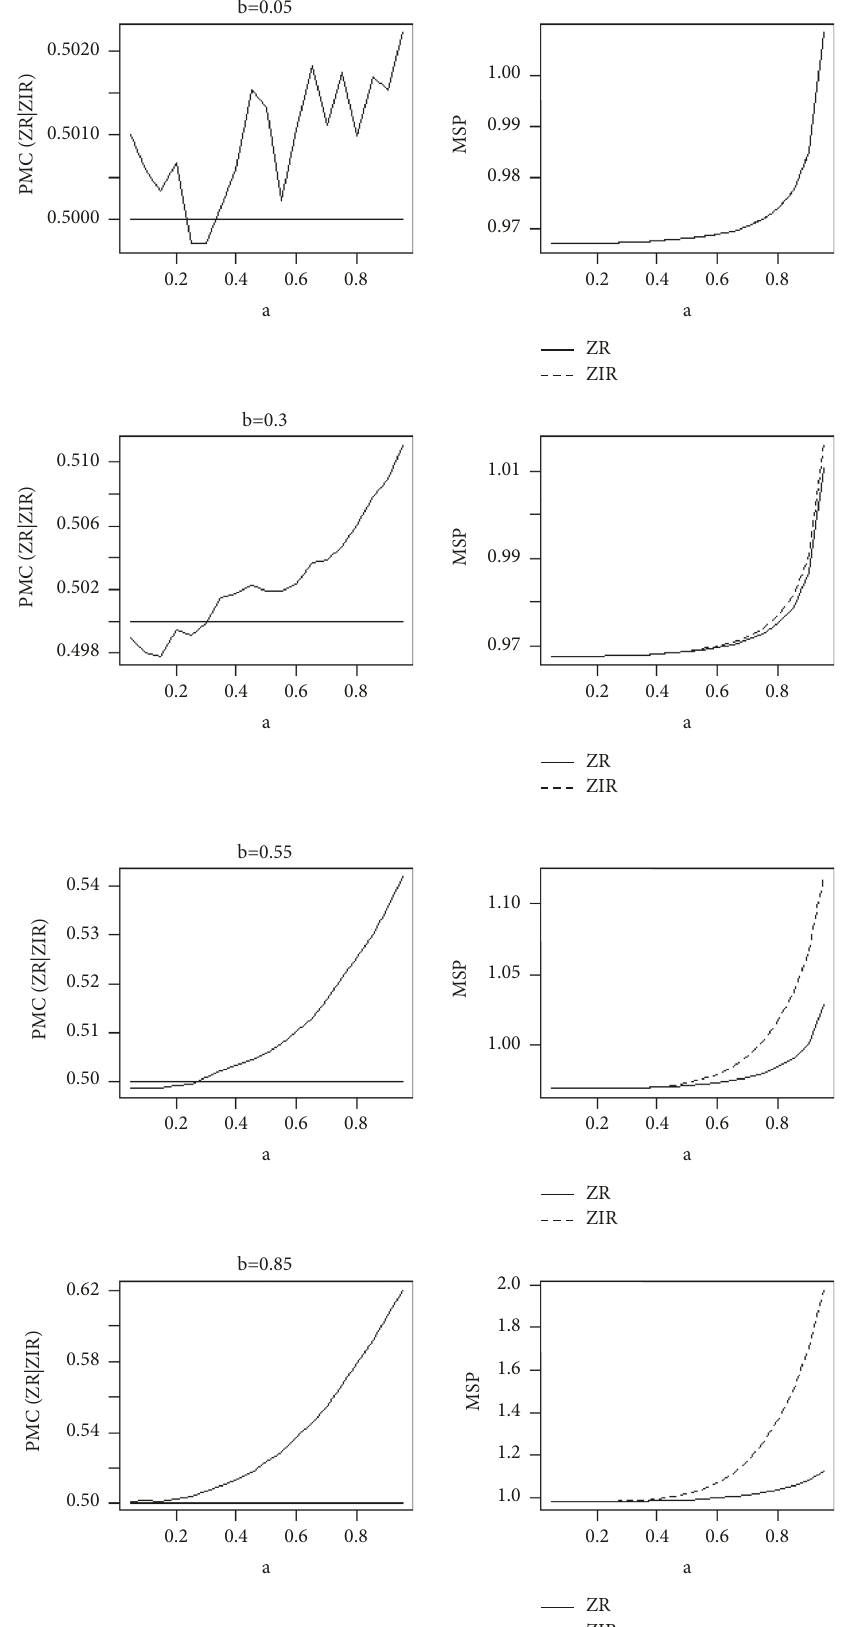
Figure 4: Comparison between 􏽢 Z R and 􏽢 Z IR for some fixed a and all b . Here, innovations have normal